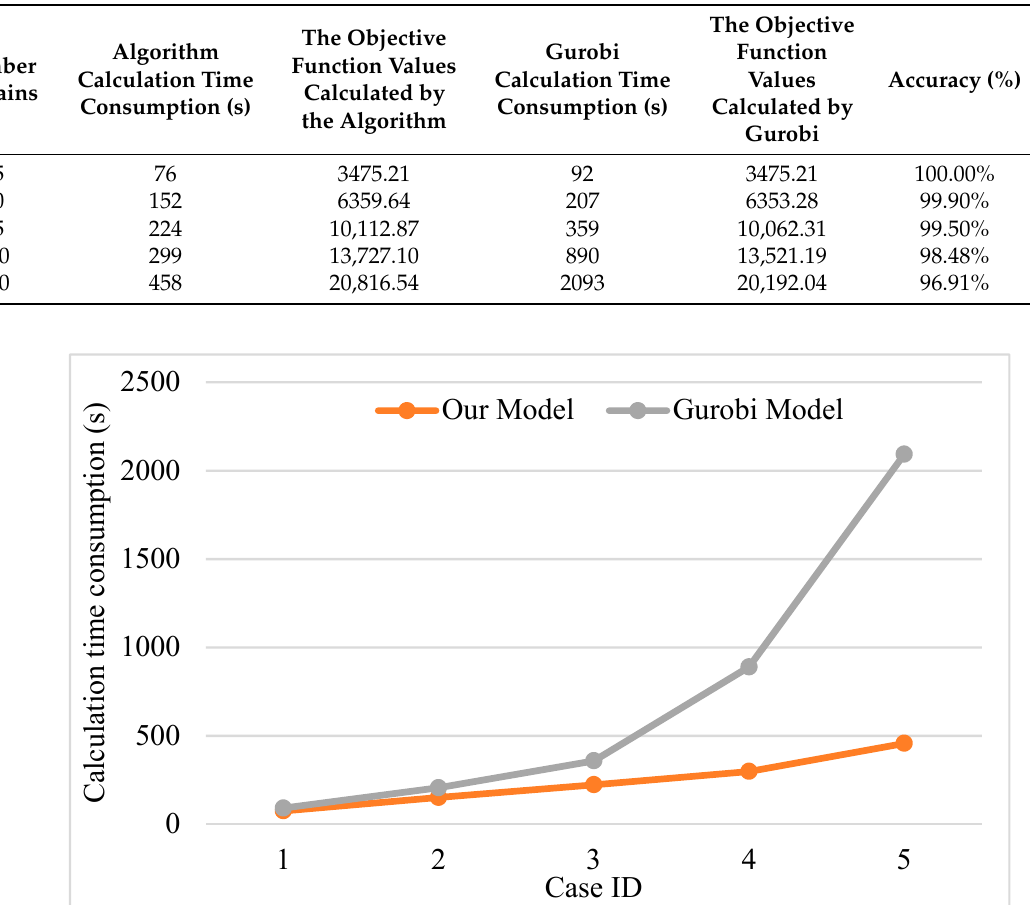
Table 16. Comparison table of algorithm efficiency and accuracy for different cases.